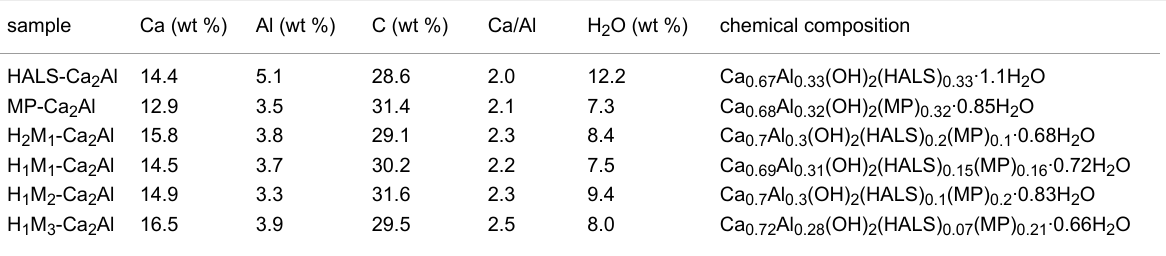
reflection (002) peaks of HALS-Ca 2 Al and MP-Ca 2 Al clearly appear (marked with “†”) with an increase in spacing from